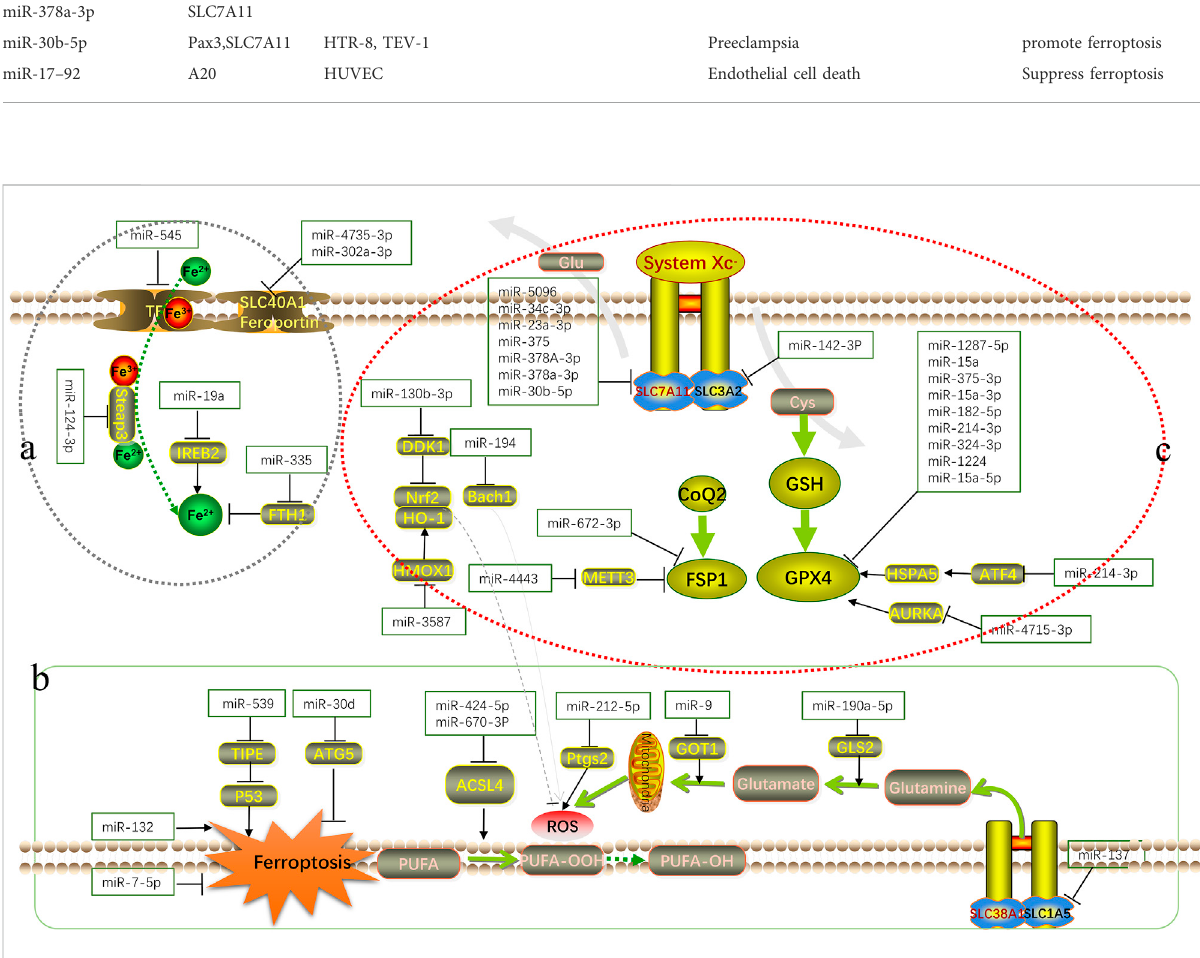
FIGURE 1 Schematic overview of the mechanism of microRNA in ferroptosis. MicroRNAs regulate various biological processes in the occurrence and developmentofferroptosisbyinterferingwithironmetabolism( (A) :accumulation processofintracellularFe 2+ ),lipidperoxidation( (B) :accumulation process of ROS and other peroxidation products) and antioxidant systems ( (C) : antioxidant axis dominated by Xc −